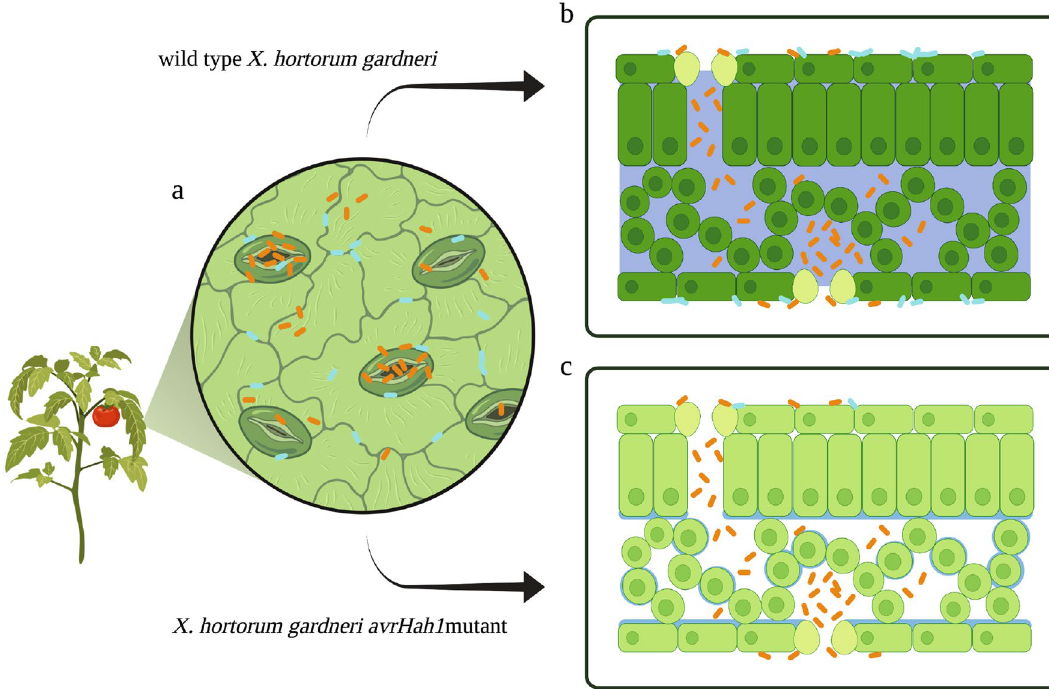
Figure 4. Model for Xhg enhancement of S. enterica persistence in water-soaked leaf tissue. Depiction of the tomato leaf surface ( a ) shows the location of bacterial cells ( Xanthomonas , orange; S. enterica , cyan). Xhg tends to cluster at stomates (pores in the leaf surface) while S. enterica has a more random distribution with some cells at cell junctions (wavy lines), stomates (large ovals), and trichomes (not shown). Cross sections of the leaf ( b , c ) indicate entry of Xanthomonas bacterial cells (wildtype Xhg, b ; Xhg avrHah1 ΔDBD mutant, c ) into the apoplastic space through stomates and some of the resulting consequences to leaf physiology. Water soaking seen during infection by wildtype Xhg is depicted by the darker green plant cells and the increased amount of water and/ or nutrients (purple) in the apoplast ( b ). This figure was adapted from “Leaf Surface Structure” and “Leaf Anatomy”, by BioRender (2021). Retrieved from https:// app. biore nder. com/ biore nder- templ